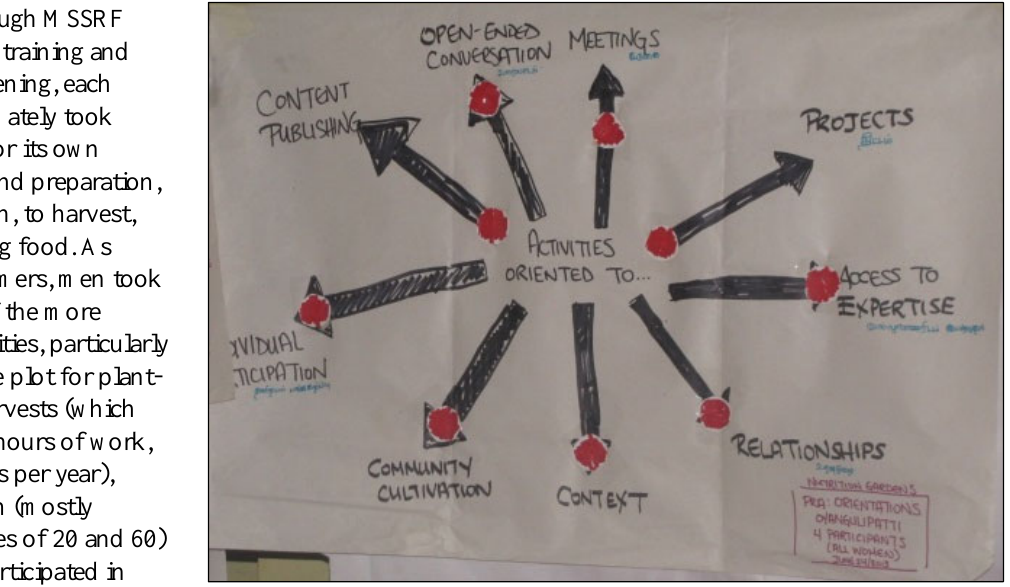
Figure 4. Orientations Participatory Rural Appraisal (PRA) Diagram